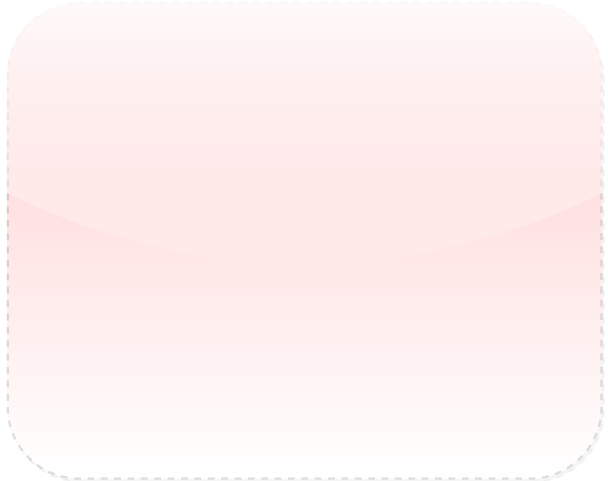
Figure 1. General framework of Internet of Things (IoT) + Fog +